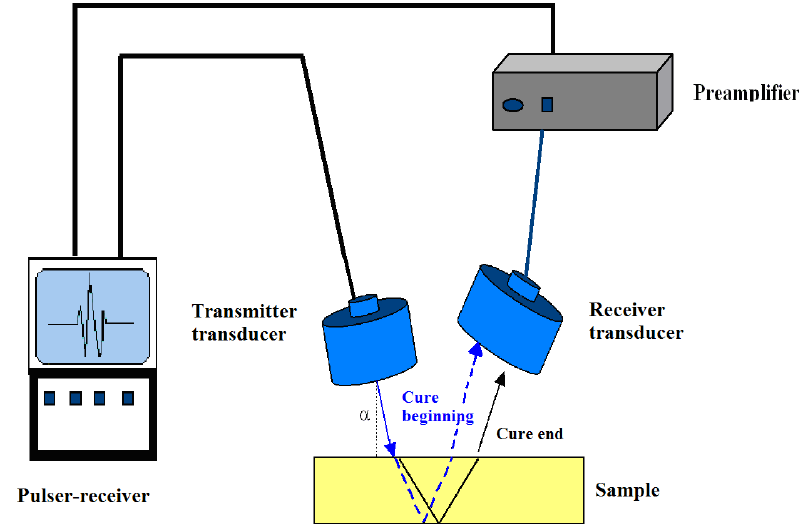
Figure 10. Experimental set-up for the generation and detection of longitudinal waves by air-coupled ultrasound in the pitch-catch mode (adapted from